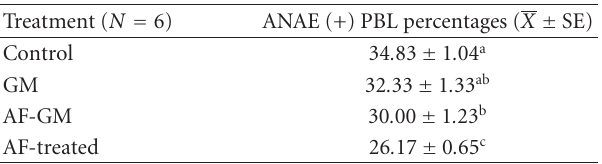
Table 1: ANAE-positive PBL rates of control and experimental groups at the end of the